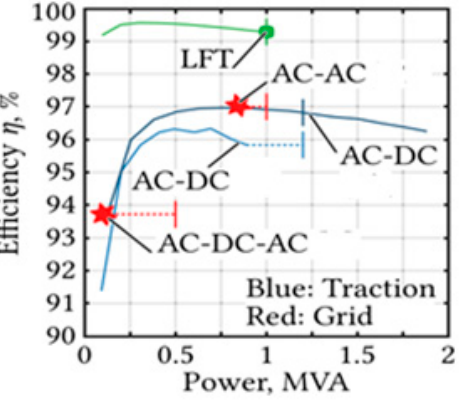
Figure 12. The efficiency curve and efficiency statistics for a 1000 kVA LFT were obtained from an industrial SST prototype system [4,9,10,27]. Reprinted with permission from Ref. [15]. 2022, IEEE.